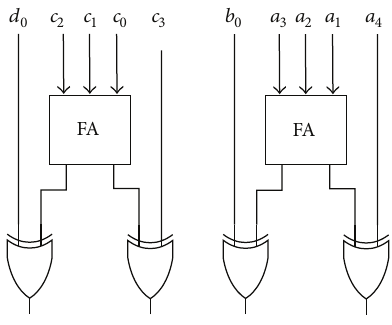
Figure 6: Boolean network for (1, 4, 1, 5; 5) GPC after node